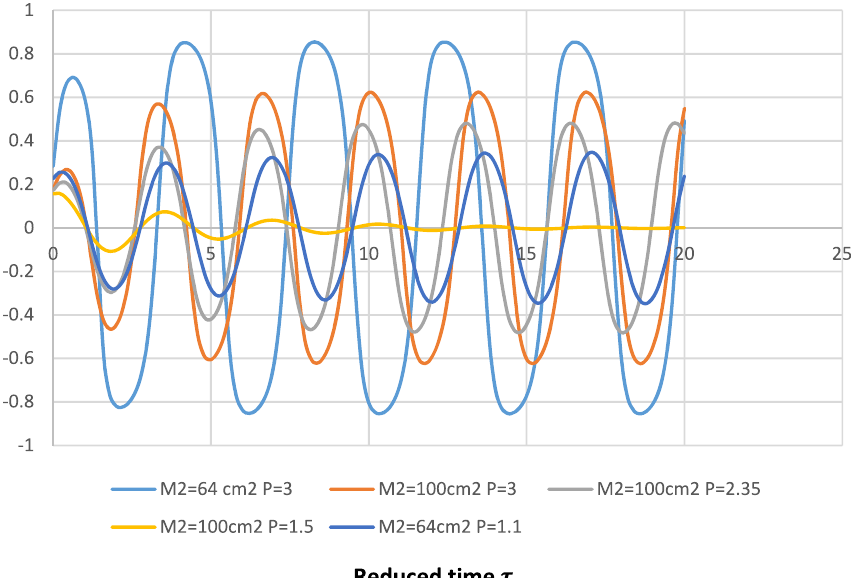
Fig. 2. Evolution of the axial offset AO p for various values of ’ ¼ P and M 2